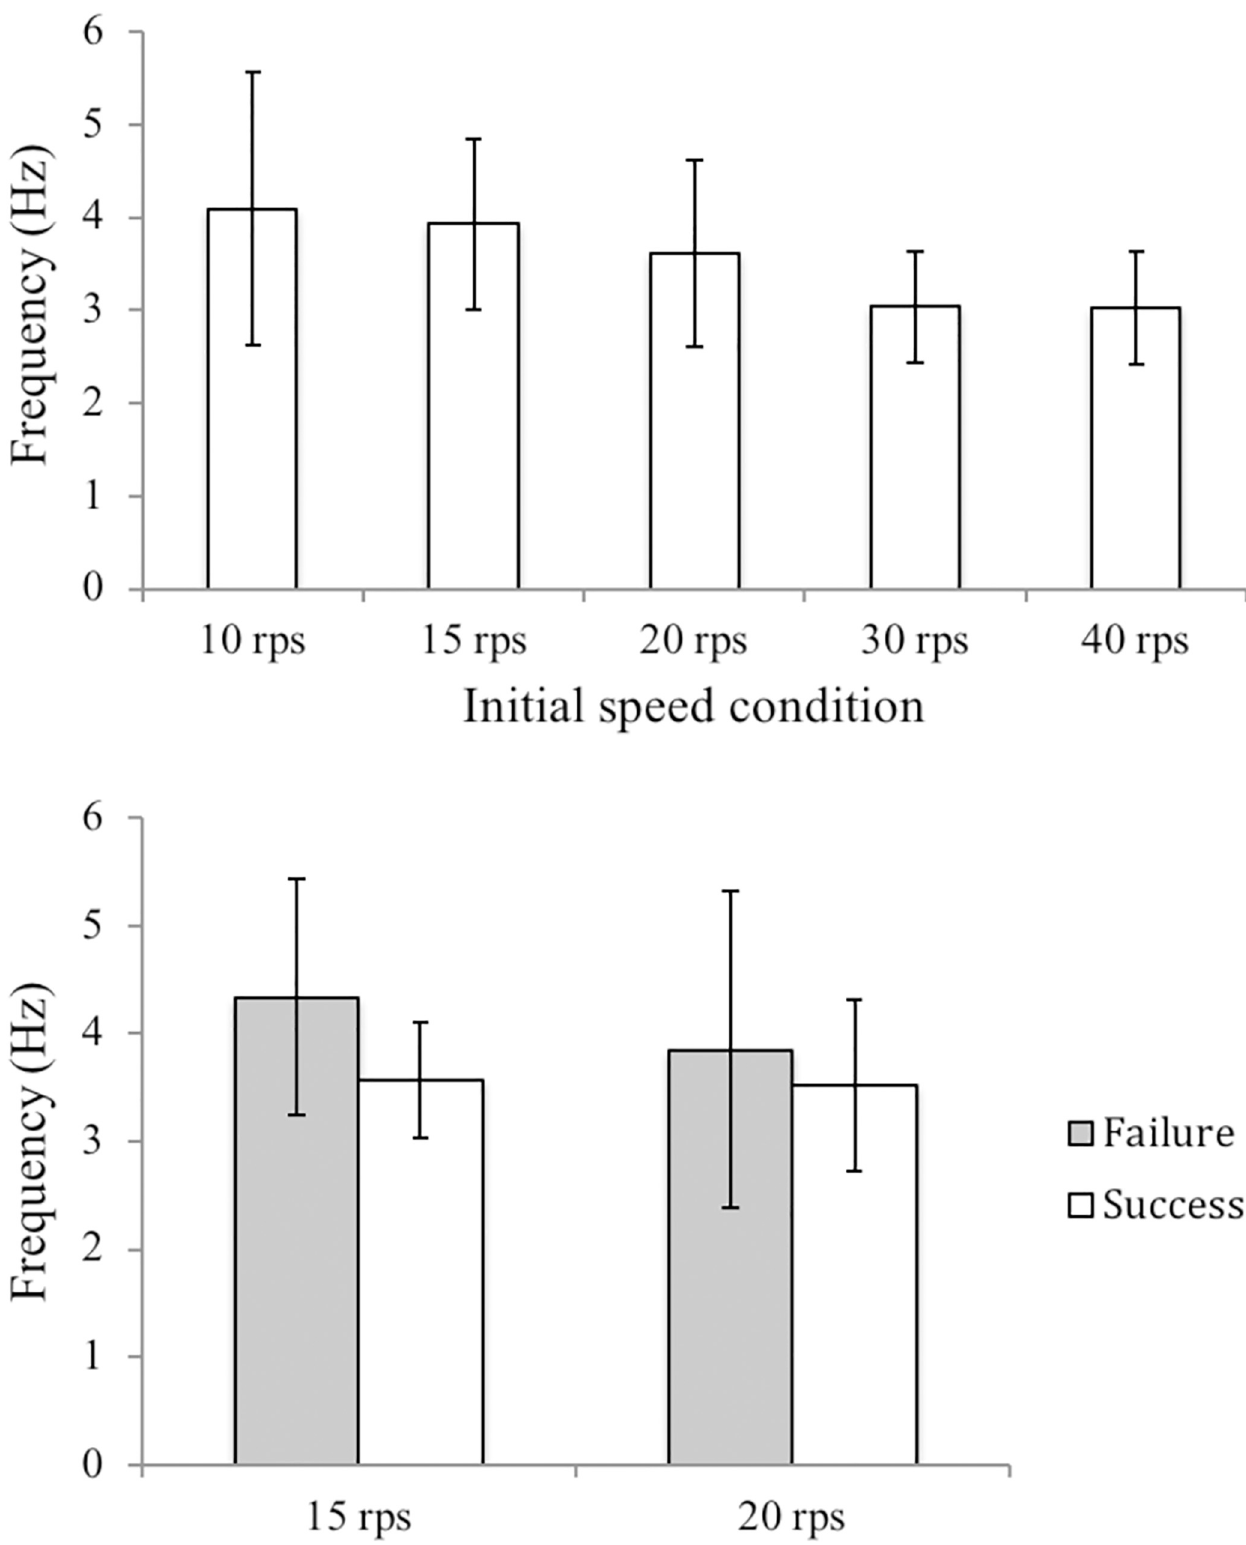
Fig 5. The top panel shows the average outer shell movement frequency of each initial speed condition from the 113 trials. The bottom panel shows the average outer shell movement frequency of the success and failure trials for the 15 rps and 20 rps initial speed conditions. https://doi.org/10.1371/journal.pone.0215460.g005 PLOS ONE | https://doi.org/10.1371/journal.pone.0215460 April 18,